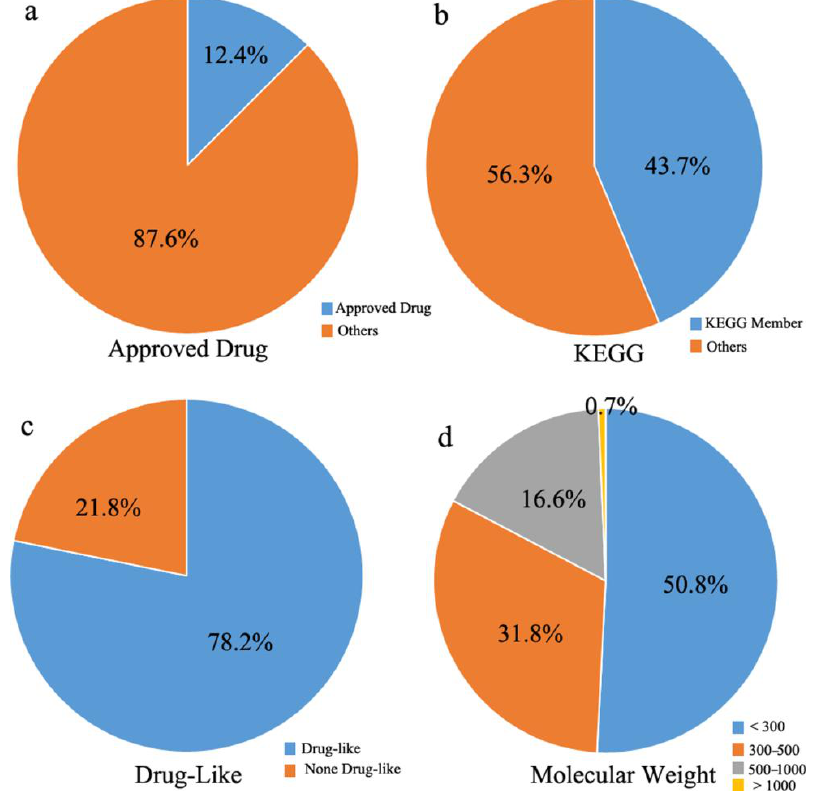
Figure 2. Statistical analyses for entries in the updated MTLD. ( a ) 304 (12.4%) entries are approved drugs from the DrugBank database; ( b ) 1069 (43.7%) entries belong to the Kyoto Encyclopedia of Genes and Genomes database; ( c ) 1911 (78.2%) entries are drug-like compounds according to Lipinski’s rule of five; ( d ) molecular weights of most ligands are ≤500 Da.